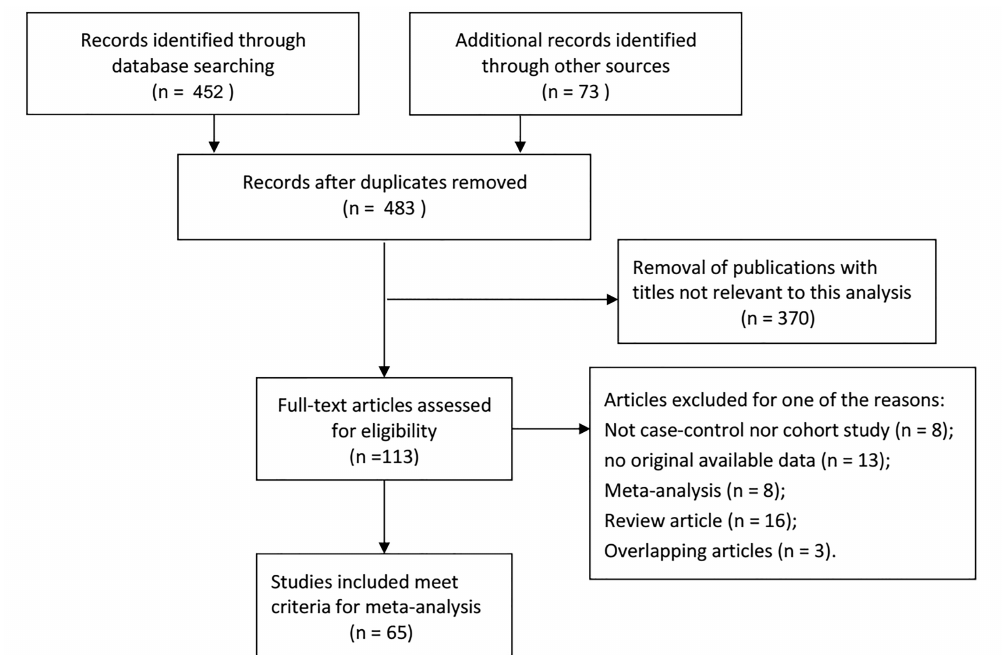
Figure 1 - Flowchart of literature search and selection